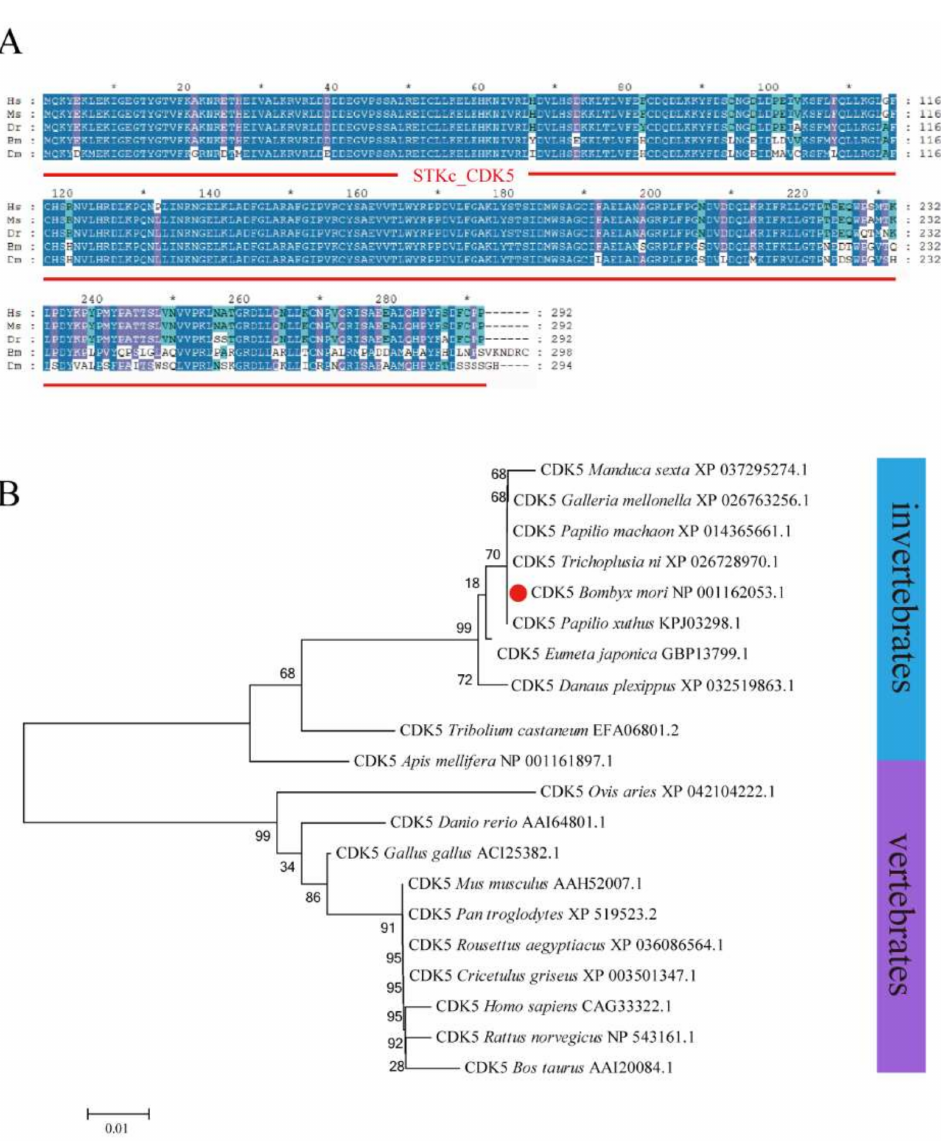
Figure 1. Homology and evolution analysis of BmCDK5. ( A ) Multiple sequence alignment of CDK5 from Homo sapiens , Mus musculus , Danio rerio , Bombyx mori and Drosophila melanogaster , containing a conservative CDK5 domain (red line). ( B ) Phylogenetic tree of CDK5 from invertebrates and vertebrates; BmCDK5 is marked by red origin. * 0.01 ≤ p <